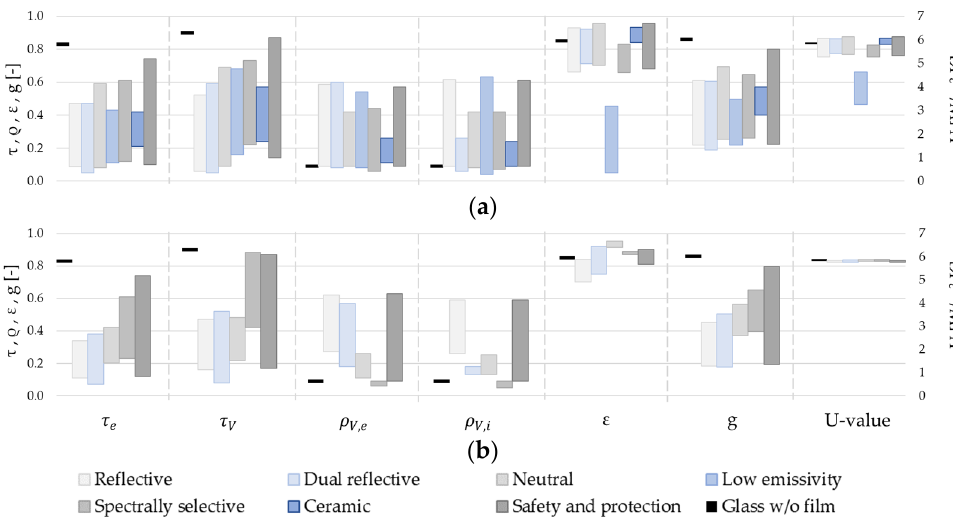
Figure 6. Ranges of values of the main thermal and solar optical properties of clear single glazing with and without different types of SCFs applied to the internal ( a ) and external ( b ) glass surfaces.